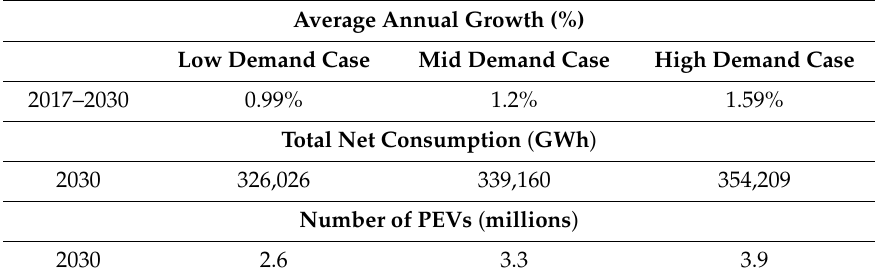
Table 6. Key variables for estimates electricity consumption in California [24,25].